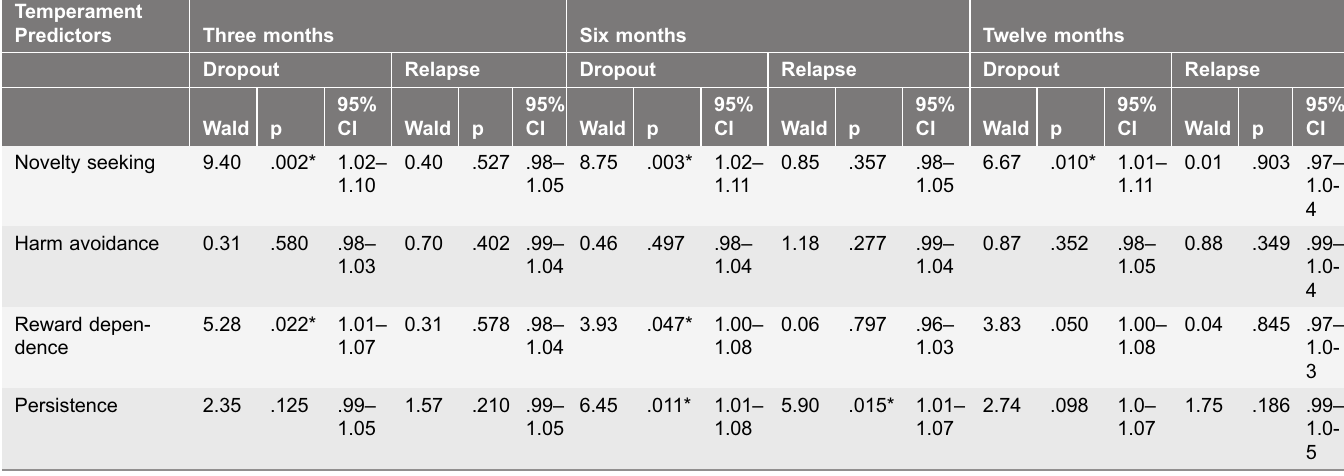
Table 3. Multinomial regression models testing the association between TCI temperament dimensions and smoking cessation treatment dropout and relapse at the 3-month, 6-month and 12-month endpoints. Temperament